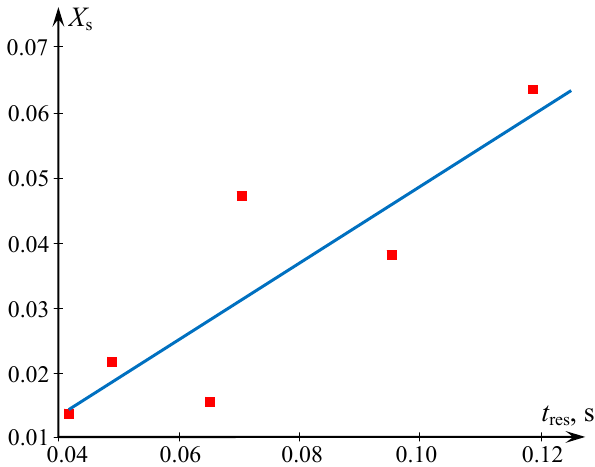
Figure 5. Dependence of the segregation index X s on the residence time in the two-step microreactor with swirled flows. Solutions were supplied to the tangential pipes (see Table 2). Points—our experimental data, blue line-linear correlation ( X s = 0.589 t res − 0.01).